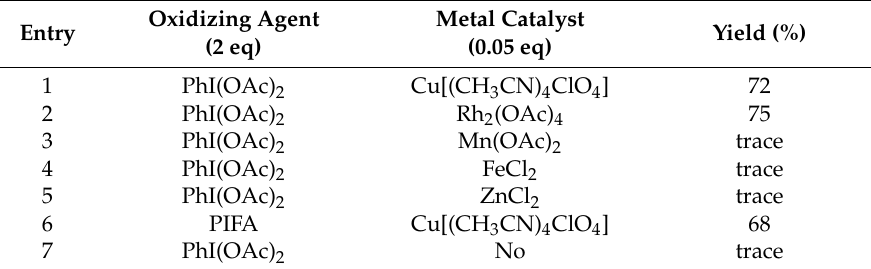
Table 1. Optimization of the reaction conditions for the formation of compound 10a .